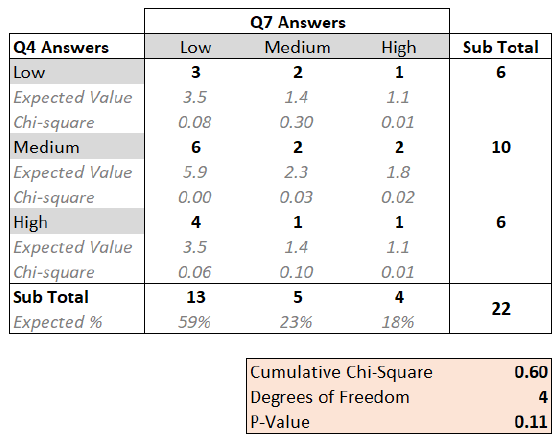
Fig. 1 – Chi-square correlation test between answers of Question 4 and Question 7 of the